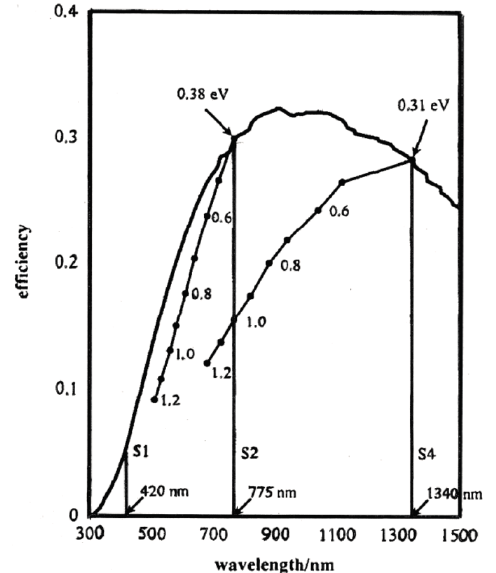
Figure 3. Solar photon-to-chemical energy conversion efficiency in a single bandgap current device (adapted from [71] with permission of